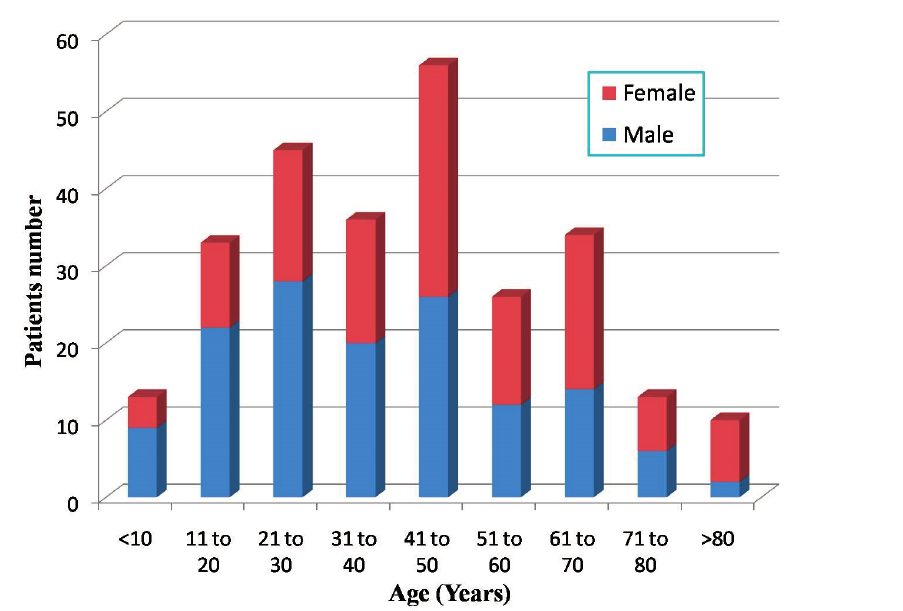
Figure 3. Age and gender distribution of the earthquake-related patients admitted to the three military hospitals.